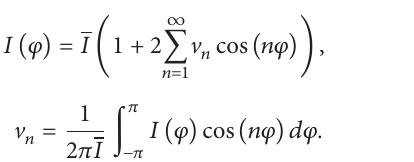
Figure 8: Energy loss per unit length by quarks moving in constant external magnetic field as a function of (a) 𝑝 𝑇 at RHIC at 𝜂 = 𝜑 = 0 , (b) 𝜂 = 𝜑 = 0 , (c) azimuthal angle 𝜑 with respect to the reaction plane for 𝑝 𝑝 𝑇 at LHC at versus rapidity 𝜂 at 𝑝 𝑇 = 5 GeV and 𝜑 = 0, 𝜋/4